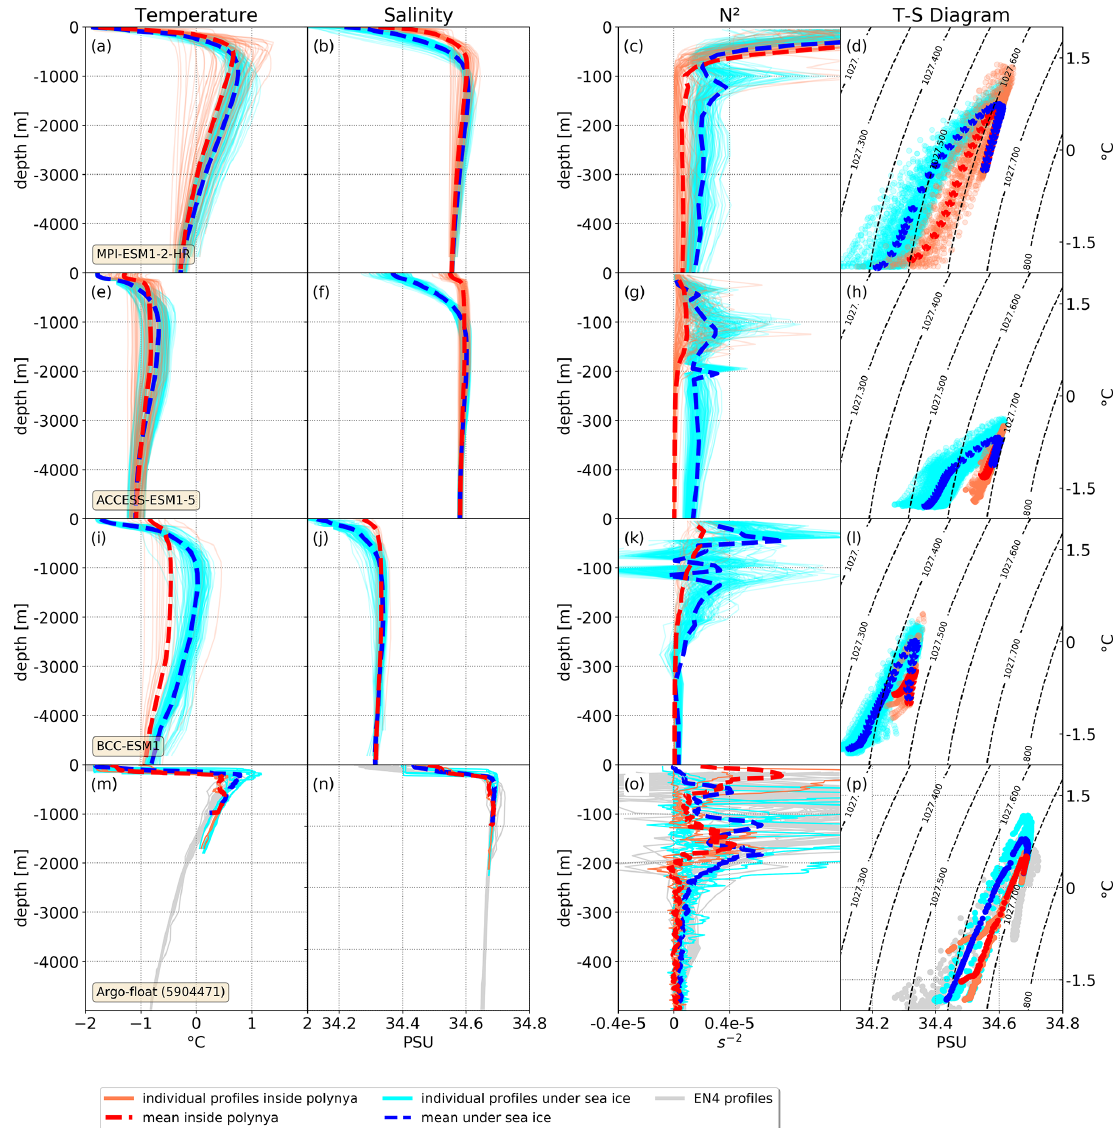
Figure 10. Winter profiles occurring within a polynya (red) and under the sea ice (blue, i.e. when no polynya is present) for three repre- sentative models (first three rows) and in observations (last row). From left to right: potential temperature, salinity, squared Brunt–Väisälä frequency ( N 2 ) and T – S diagram. Note the difference in vertical scale between the first two and the third column. The contour lines in the last column are lines of constant potential density. Two vertical Argo float profiles from within the polynya are available; for comparison we plot 19 under-sea-ice profiles (blue) and monthly September profiles from the EN4.2.1 climatology (grey) in panels (m) – (p)